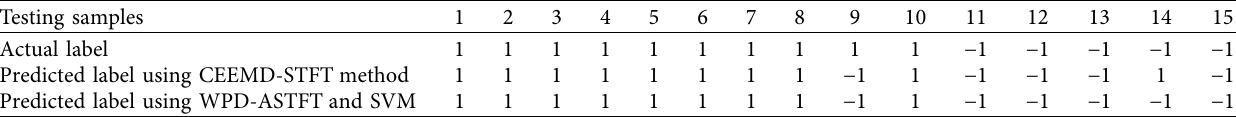
Table 5: The prediction results for the testing samples using the conventional method and the presented method. Testing samples Predicted label using CEEMD-STFT method Predicted label using WPD-ASTFT and